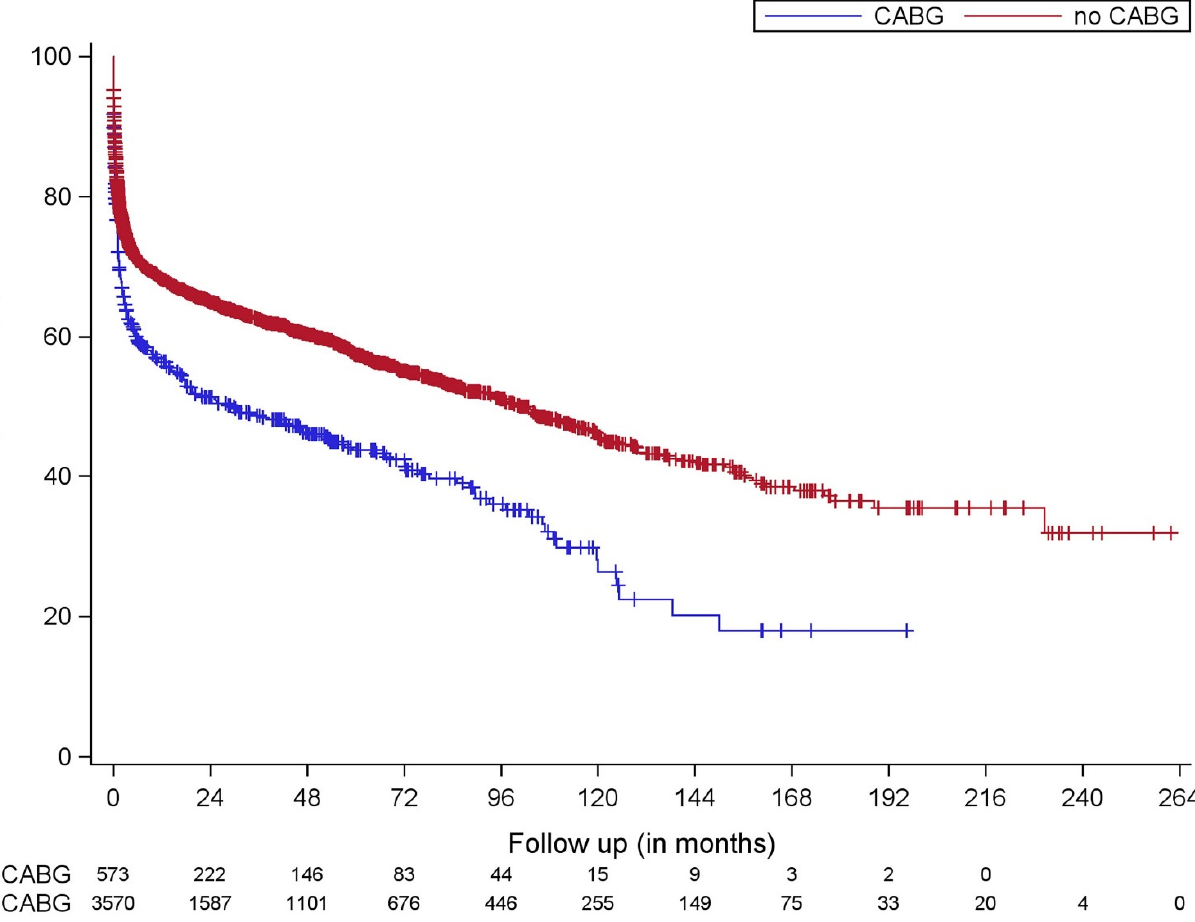
Figure 1. Kaplan–Meier estimates for survival of patients with concomitant CABG (blue line) compared to those without CABG (red line). Concomitant CABG was associated with worse survival (HR: 1.51, 95% CI: 1.33–1.71, log rank < 0.001). CABG: coronary artery bypass grafting; CI confidence interval; HR: Adjusted hazard ratio.